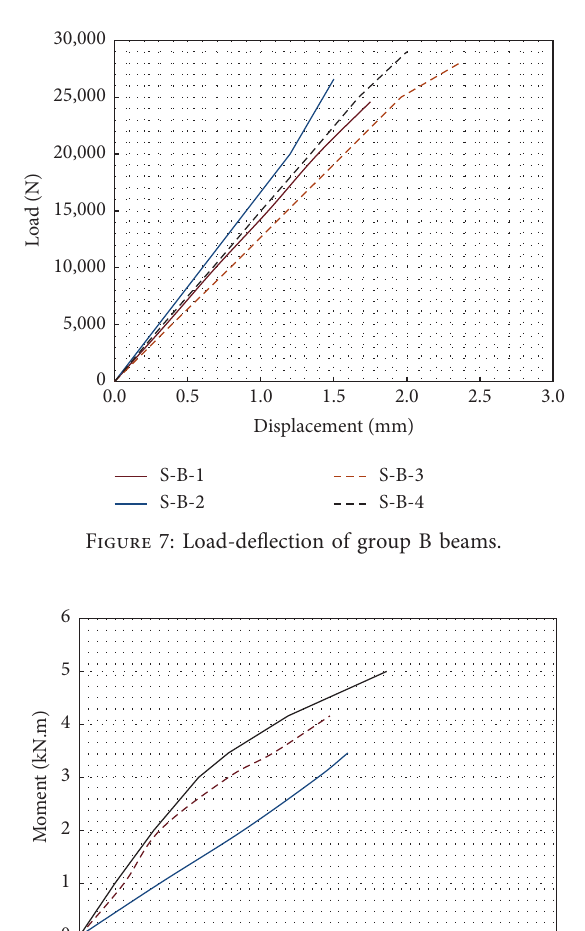
Figure 9: Relation between moment and strain at midspan of top flange (group B beams).